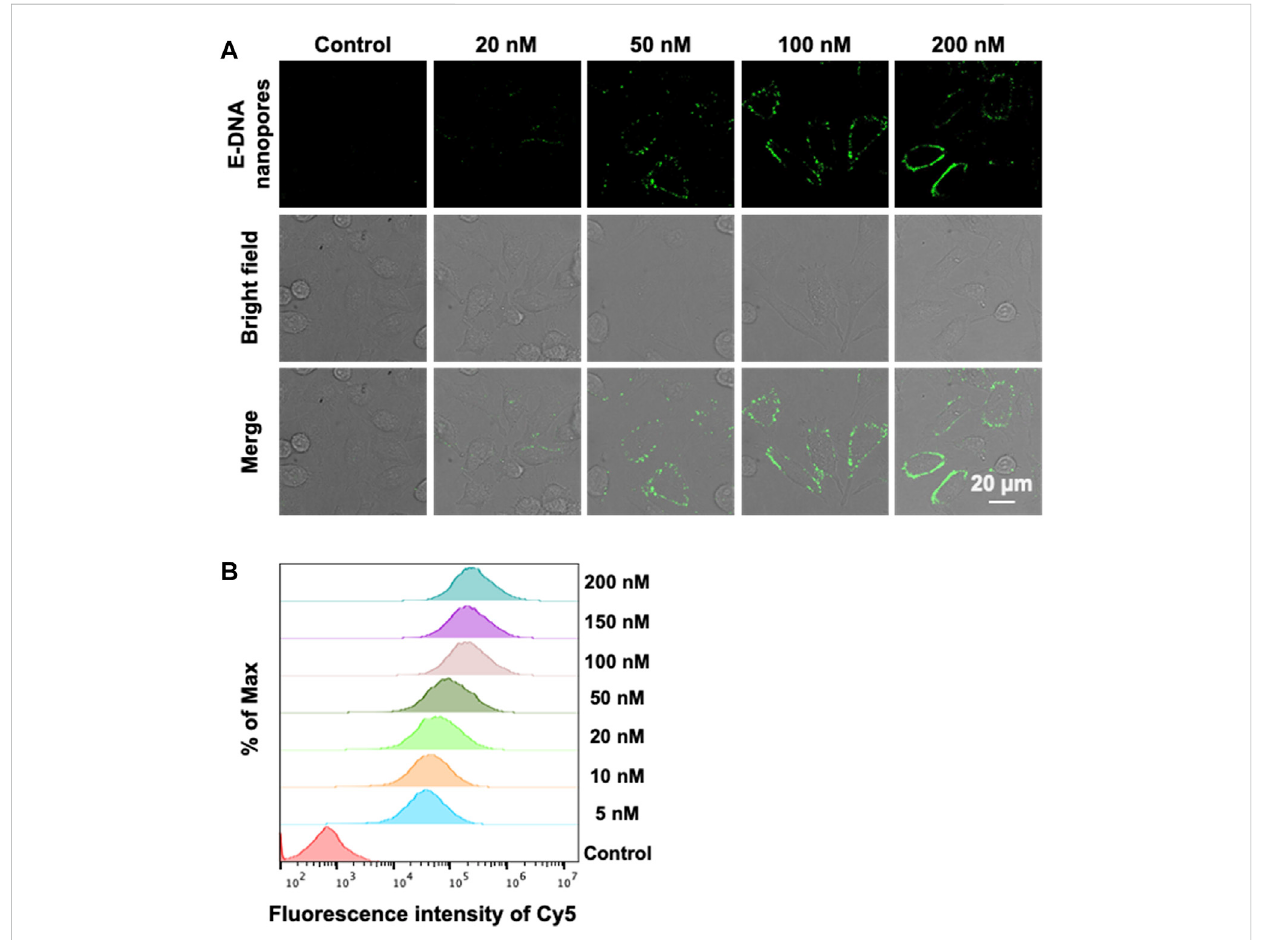
FIGURE 3 (A) Confocal images of MCF-7 cells incubated with different concentrations of E-DNA nanopores. Scale bar: 20 μ m. (B) Flow cytometry analysis of MCF-7 cells incubated with different concentrations of E-DNA